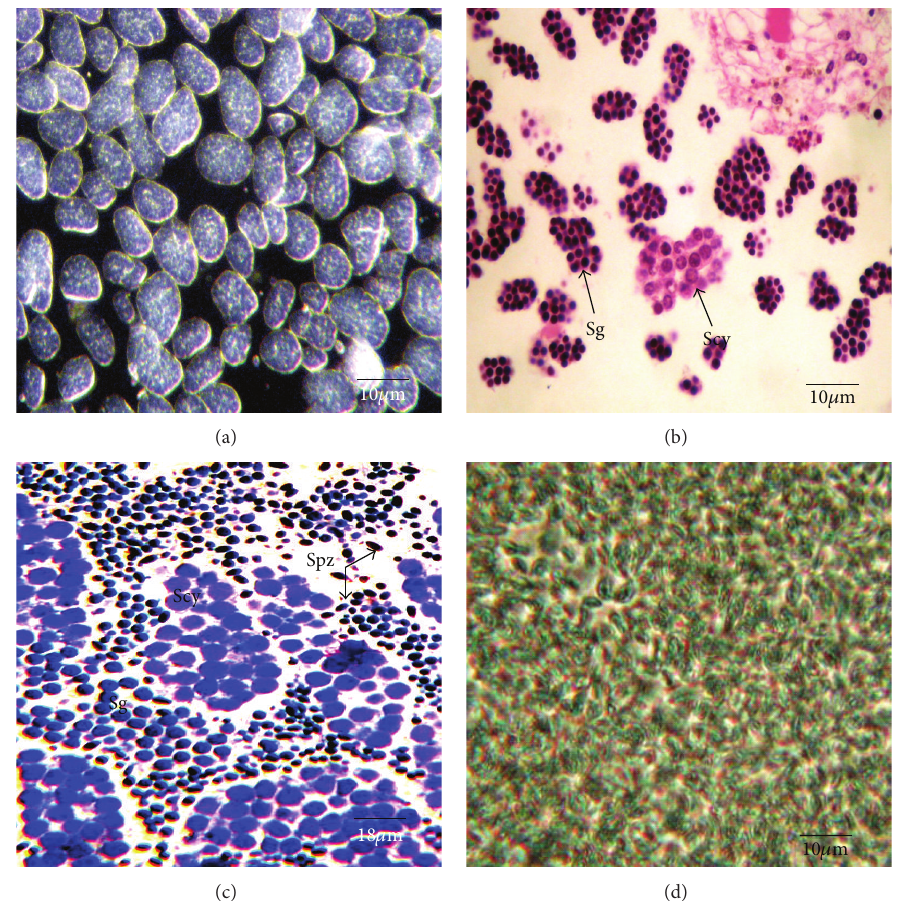
Figure 3: Spermatogenesis. (a) Coelomic fluid from a male collected in June showing early germ cells arranged as mulberry-like clusters; (b) clusters of spermatogonia (Sg) and primary spermatocytes (Scy) in the coelomic fluid of a male collected in July; (c) coelomic fluid from a male collected in October containing sperm in all stages of development: spermatogonia (sg), primary spermatocytes (Scy), and spermatozoa (Spz); (d) coelomic fluid of a mature male collected in December showing free sperm.